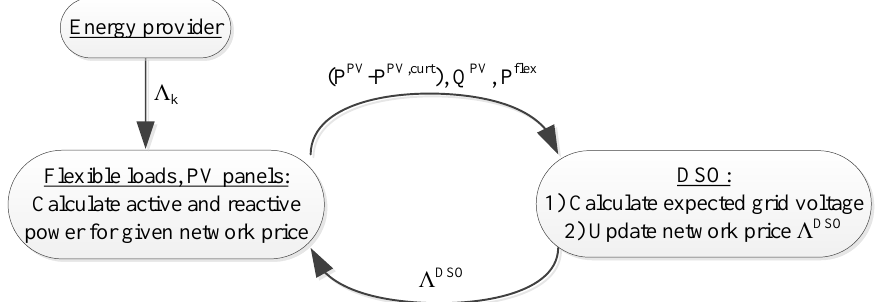
Figure 4. Flowchart of the distributed locational pricing scheme.